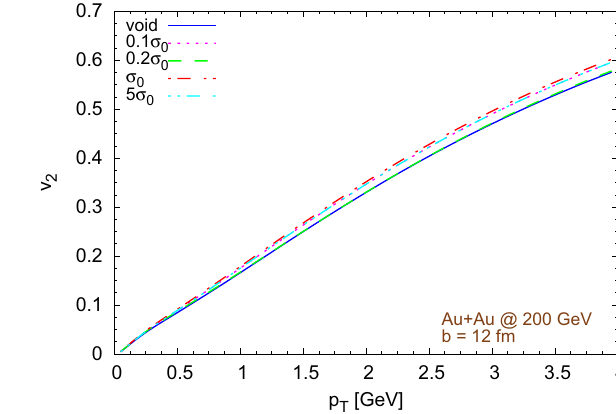
and multiplied by a factor 3. Both figures refer to Au+Au collisions at √ s NN = 200GeV, with b = 10fm (left) and b = 12fm (right)